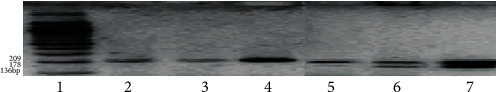
Allele-specific PCR-Arg72Pro. Lanes: 1: molecular weight marker; 2-4: β-globina amplicon 209 bp: S1 (paraffin block sample—1986), S2 (paraffin block sample—2002), H (HeLa); 5-7: Arg72Pro P53 amplicons (178 bp Pro, 136 bp Arg): S1, S2, and H (HeLa: heterozygous genotype Arg72Pro).